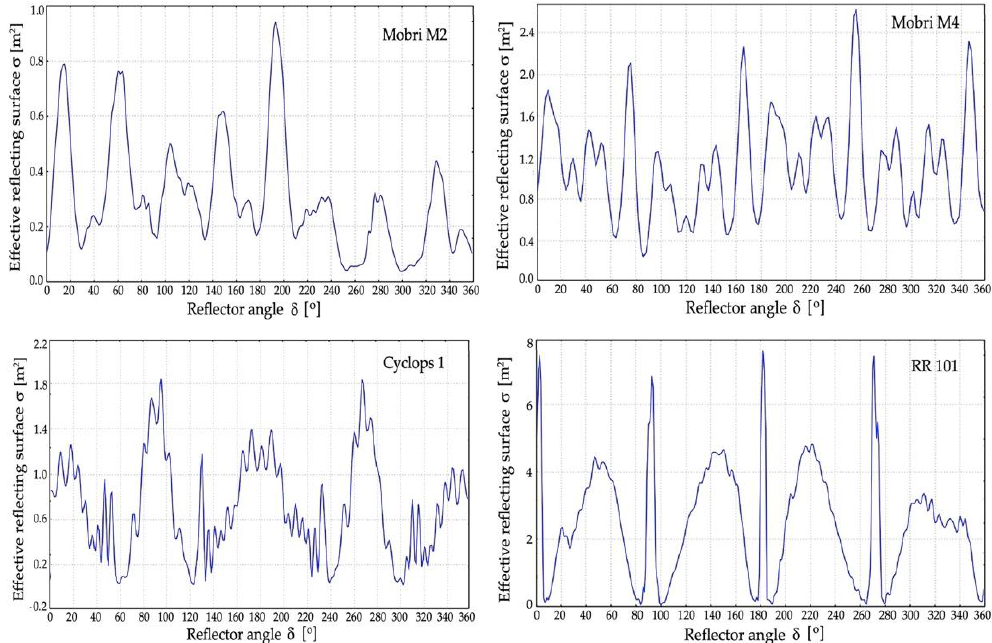
Figure 5. Values of the effective reflecting surface σ of the Mobri M2, Mobri M4, Cyclops 1, and RR 101 reflectors as a function of the angle δ of rotation.